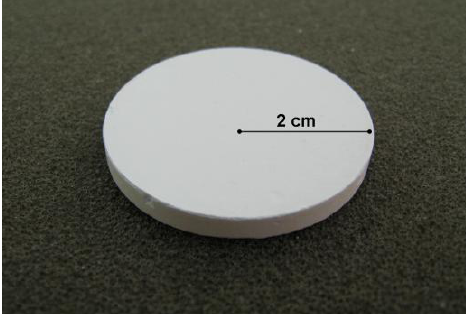
Figure 8. Digital image of a HA/BG_Ca scaffold treated at 750 °C for 3